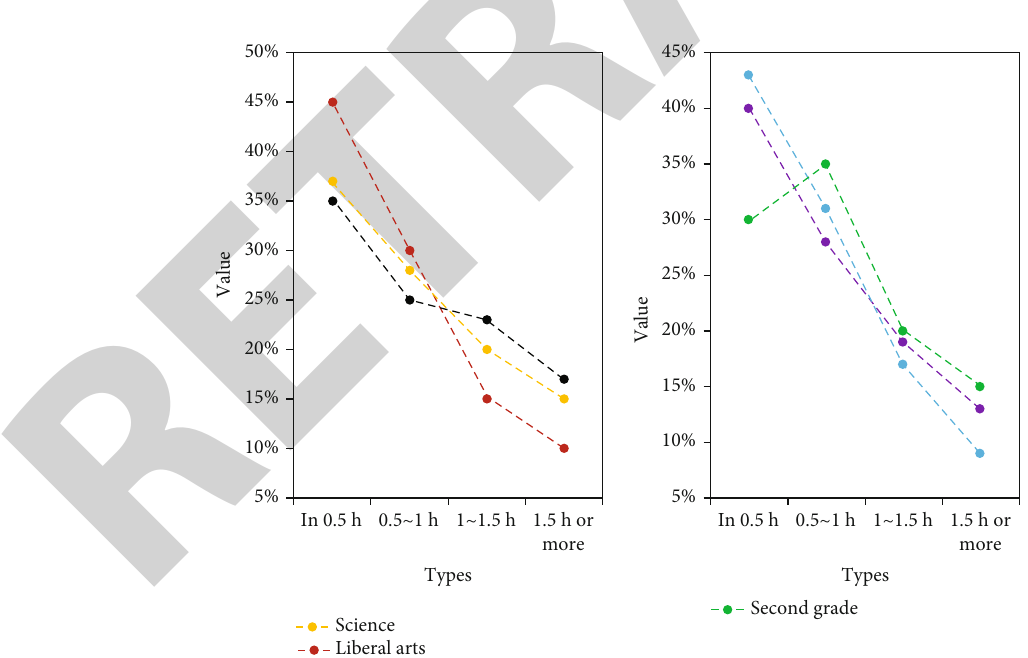
Figure 4: Exercise time and frequency of students of di ff erent genders.